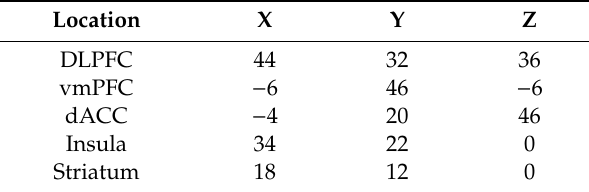
Table 1. Coordinates of center location of seed regions.